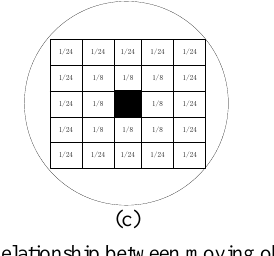
Figure. 3 Relationship between moving object and neighborhood origin point. (a) exclusion, (b) inclusion, (c) true